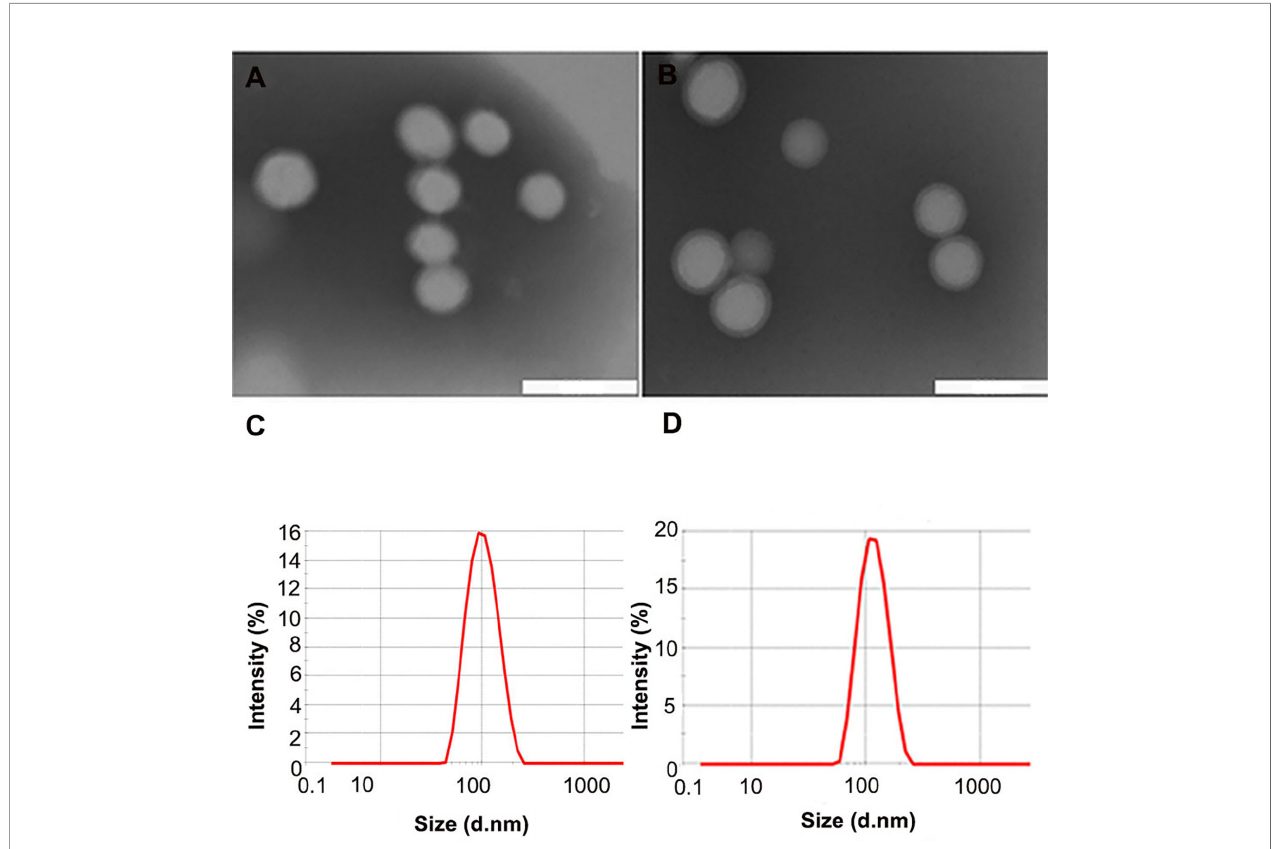
FIGURE 1 | Characteristics of different nanoparticles. (A, B) TEM scan of NPs and ENPs; (C, D) Size distribution of NPs and ENPs by DLS with He-Ne laser at 632.8 nm. (scale bars 200